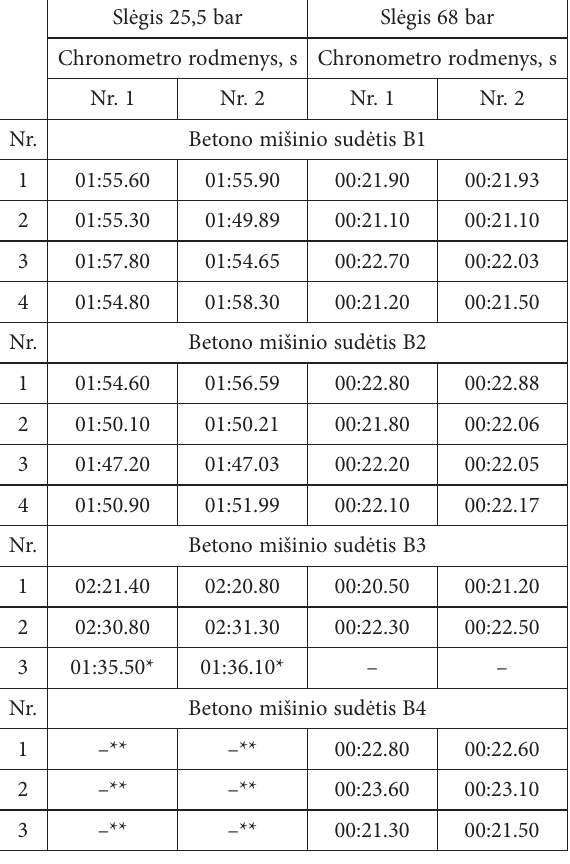
Table 6. Concrete mixtures transported by pumps